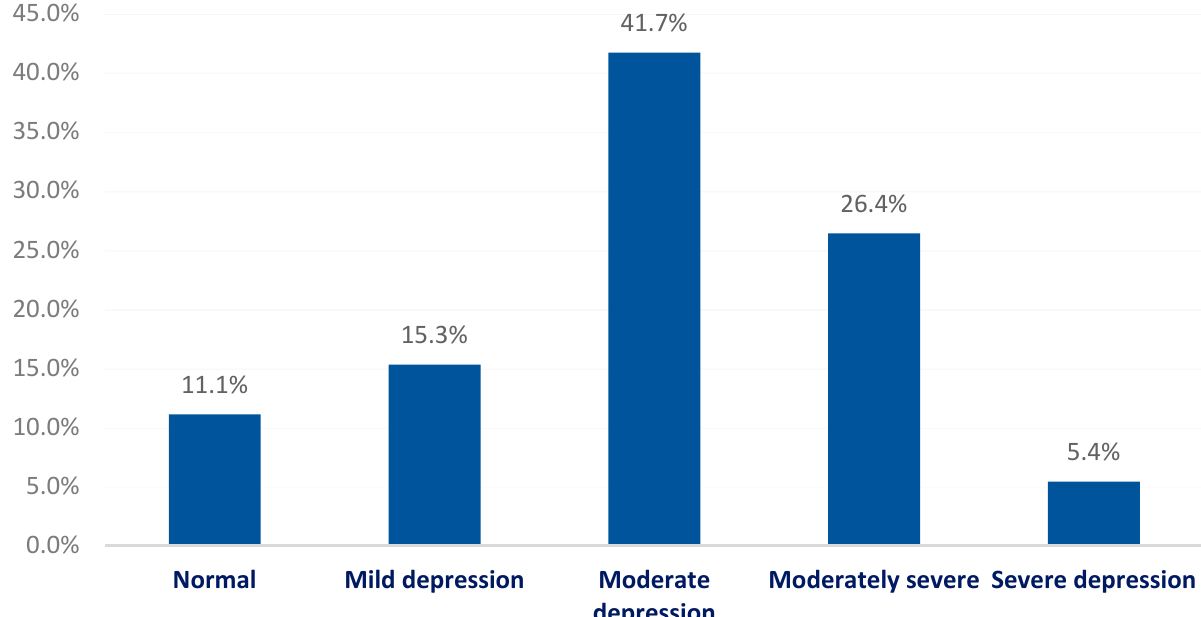
Figure 2. Depression severity among medical students at King Khalid University, Saudi Arabia.